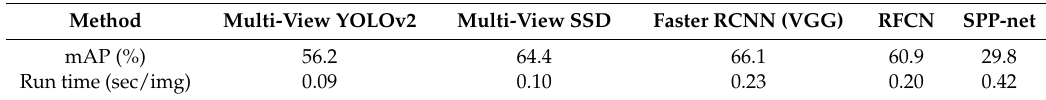
Table 4. Small object detection performance on the VOC 2007